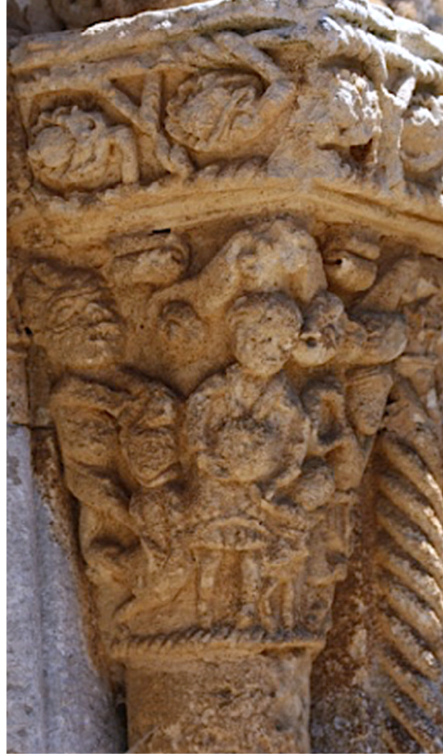
Figure 30. Historiated capital, detail of right-hand side, west façade, Saint-Martin Church , 12th c., Besse, Dordogne, Nouvelle-Aquitaine, France. ©Author.